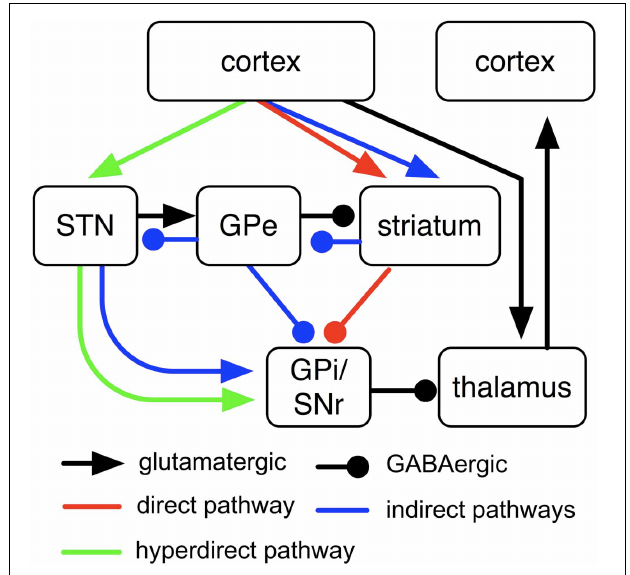
FIGURE 1 | Sketch of cortico-BG-thalamic fiber tracts and their subdivision into direct, indirect and hyperdirect BG pathways (cf. Bolam et al., 2000). Of the “indirect pathway,” two routes have been proposed (Smith et al., 1998), the short one of which passes from GPe directly to GPi, while the longer one additionally passes through STN.